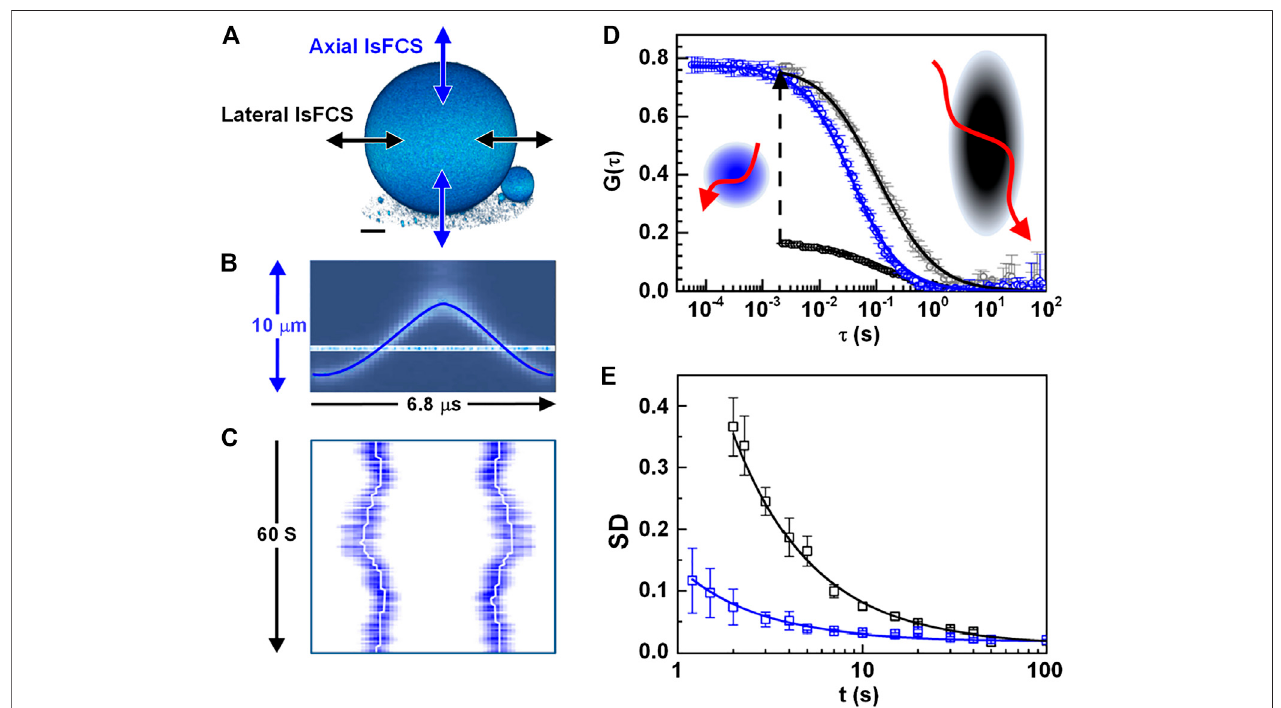
FIGURE 6 | Lateral and axial line-scanning FCS (lsFCS). ( A ) The scanning schemes of lateral and axial lsFCS, which have the observation area A (cid:2) πω 0 z 0 , and A (cid:2) πω 02 , respectively. ( B ) Axial focus position during a single oscillation cycle of 6.8 μ s in the axial lsFCS using a TAG lens. ( C ) The kymograph during 60s of axial line- scanning in the axial lsFCS. White-lines mark the membrane positions. ( D ) The correlation curve of the lateral (black) and axial (blue) lsFCS. The lateral lsFCS autocorrelation data have also been scaled to the axial ones (gray) for better comparison. ( E ) Standard deviation (SD) of two groups of seven normalized lateral (black) and axial (blue) lsFCS curves. Adapted from Ref.